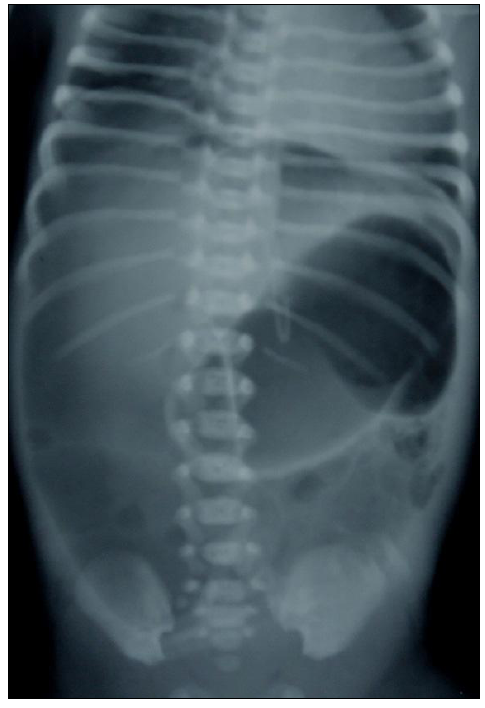
Figure 1: Plain X-ray abdomen showing pneumoperitoneum with loculated air pockets and distended